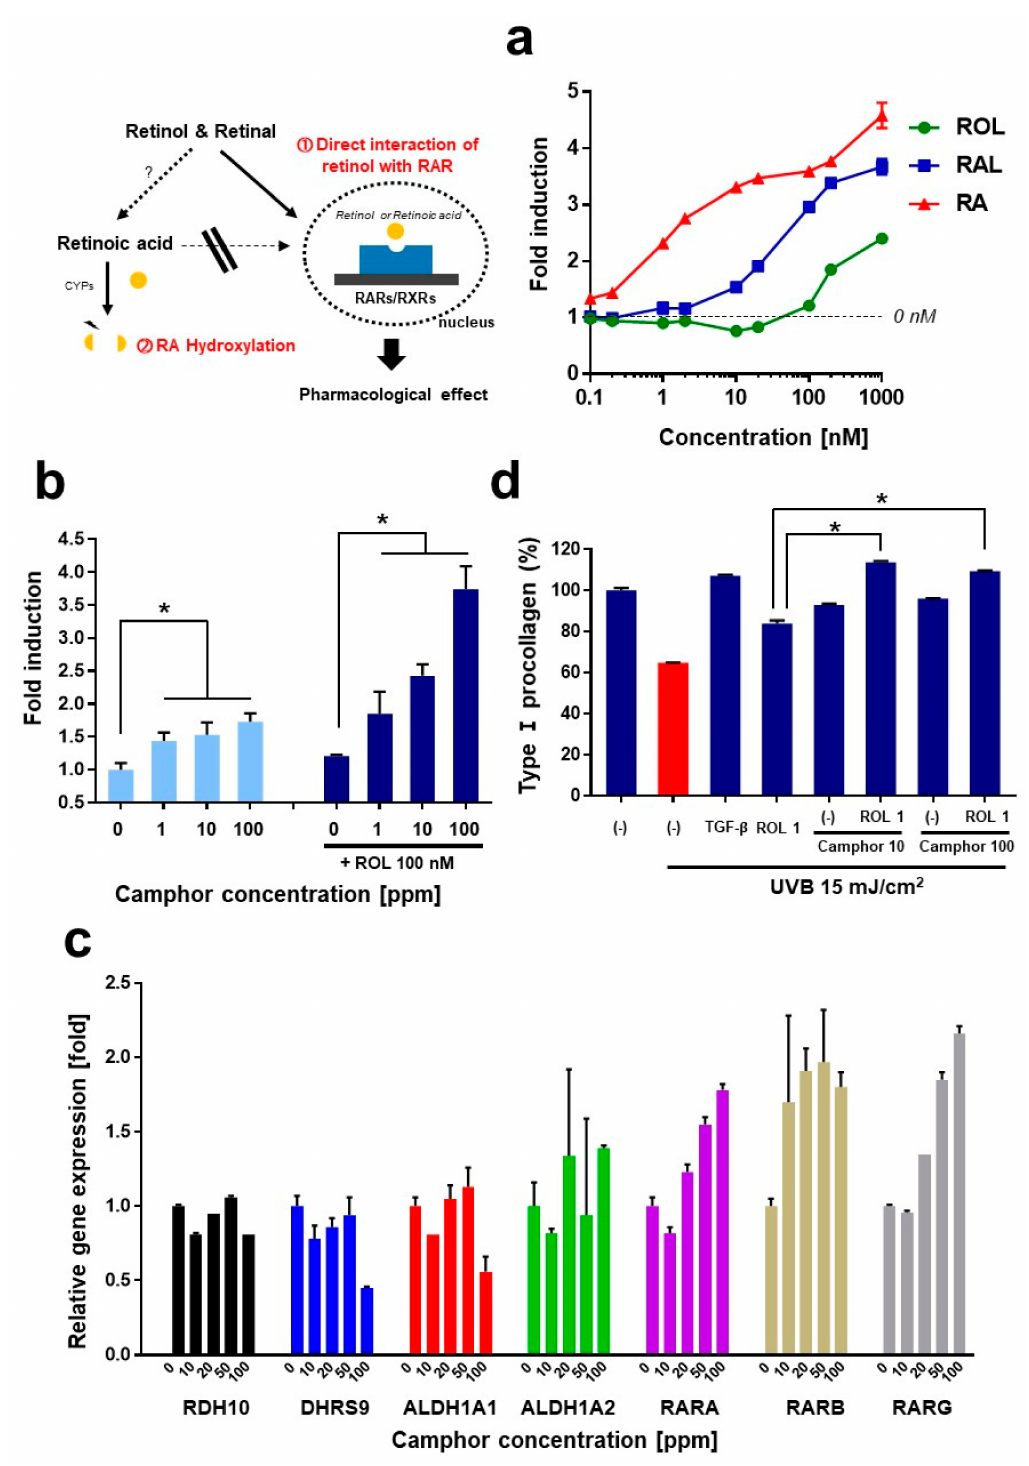
Figure 1. RAR- γ activation by retinoids and camphor. ( a ) RAR- γ activation by retinoids. Retinoic acid (RA), retinaldehyde (RAL), and retinol (ROL) were analyzed. RAR- γ activation in the reporter cell line was measured by luciferase activity. ( b ) RAR- γ activation by camphor. ( c ) Relative mRNA expression of retinoid metabolism-related genes. ( d ) Type-1 procollagen expression of fibroblast. * Significantly different results (Student’s t -test, p <